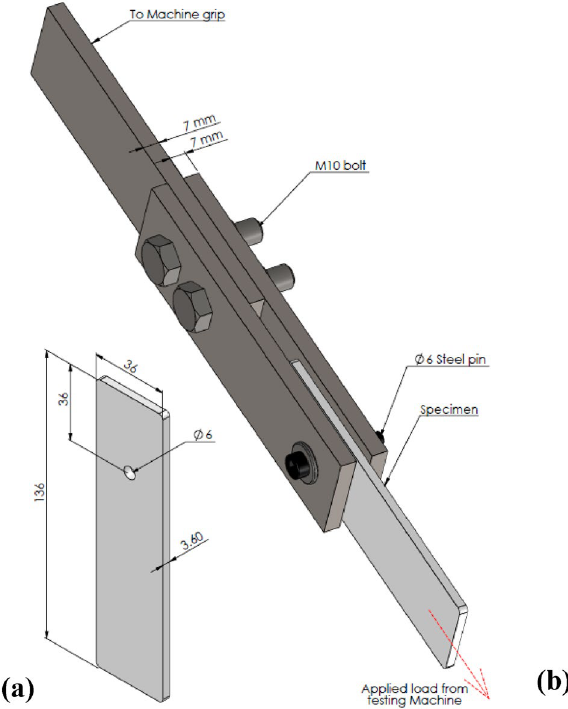
Figure 2. Bearing test specimen and fixture; ( a ) bearing specimen, ( b ) bearing